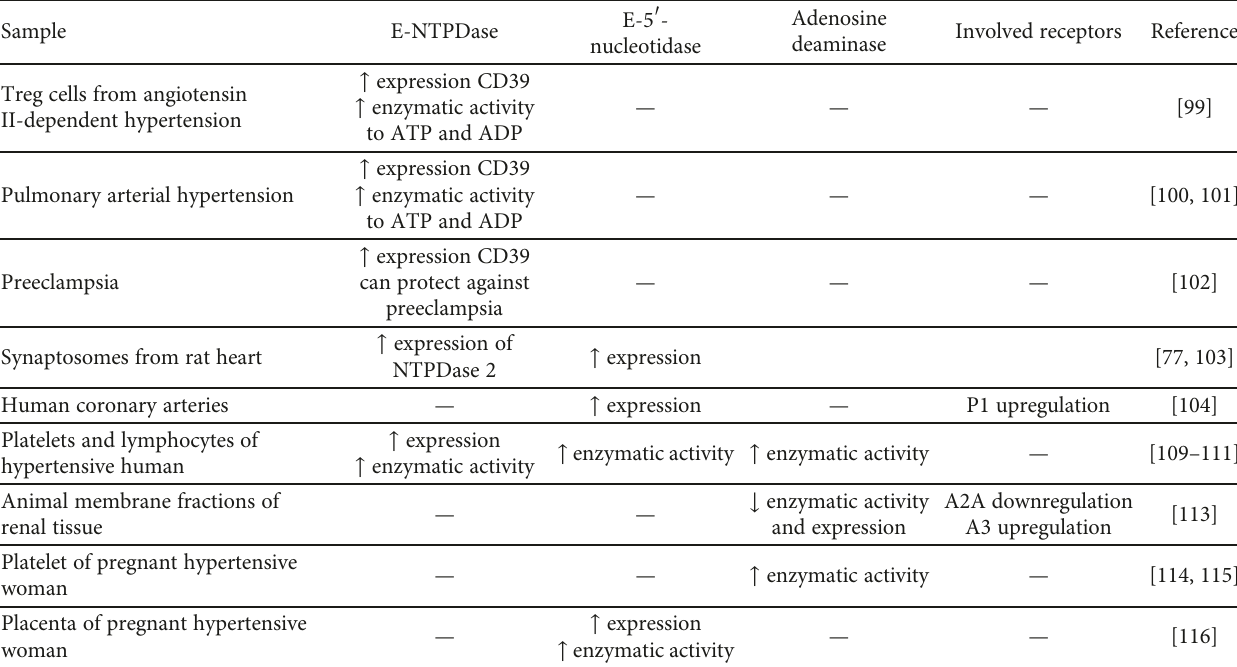
Table 2: Ectonucleotidases (E-NTPDase, E-5 ′ -nucleotidase, and ADA) and purinergic receptors in experimental models and patients with